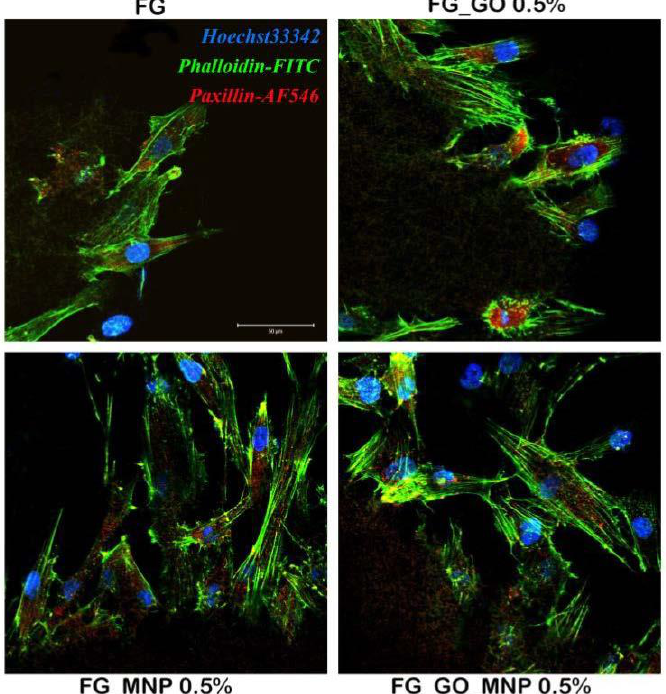
Figure 7. Development of the hASC cytoskeleton in contact with FG, FG_GO 0.5%, FG_MNP_0.5%, and FG_GO_MNP_0.5% after 48 h post-seeding. F-actin filaments are stained in green with phalloidin-FITC, paxilin in red with AF546, and cell nuclei are stained in blue with Hoechst 33342. Scale bar = 50 µm.